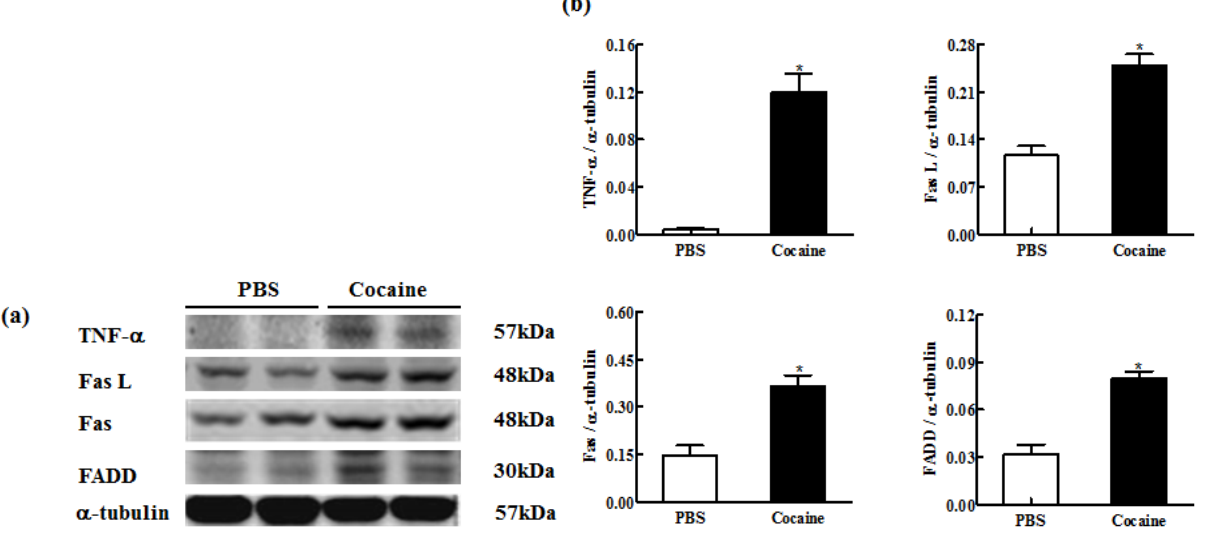
Figure 2. ( a ) The representative protein products of tumor necrosis factor-alpha (TNF- α ), Fas ligand (Fas L), Fas receptor (Fas) and Fas-associated death domain (FADD) extracted from the left ventricles of excised hearts in 2 Wistar rats with PBS exposure (PBS), 2 Wistar rats with cocaine exposure (Cocaine) as measured by Western blotting analysis. α -tubulin was used as an internal control; ( b ) Bars represent the relative changes of protein quantification on the basis of α -tubulin in TNF- α , Fas L, Fas and FADD and indicate mean values ± SD ( n = 6 in each group). * p < 0.05, significant differences between PBS and Cocaine.